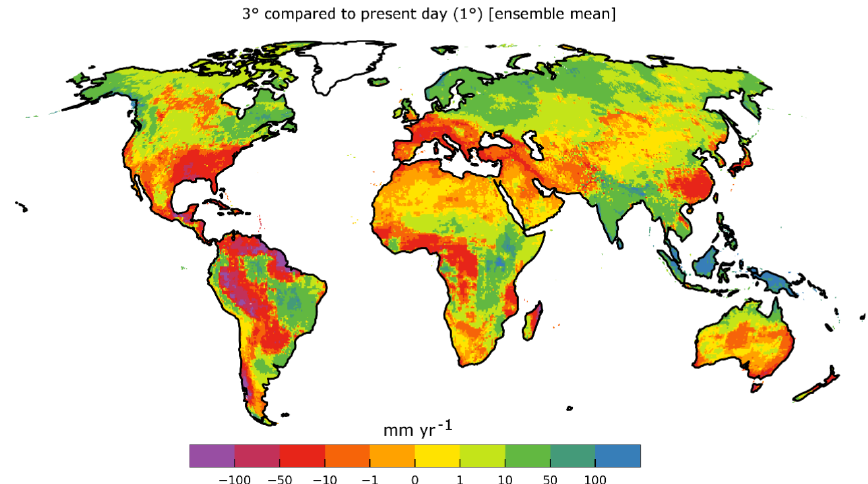
Figure 2. Ensemble mean change in GWR (mmyr − 1 ) between conditions of present-day warming of 1 ◦ C GW and at 3 ◦ C GW, averaged over the GWR changes of all GHM–GCM model